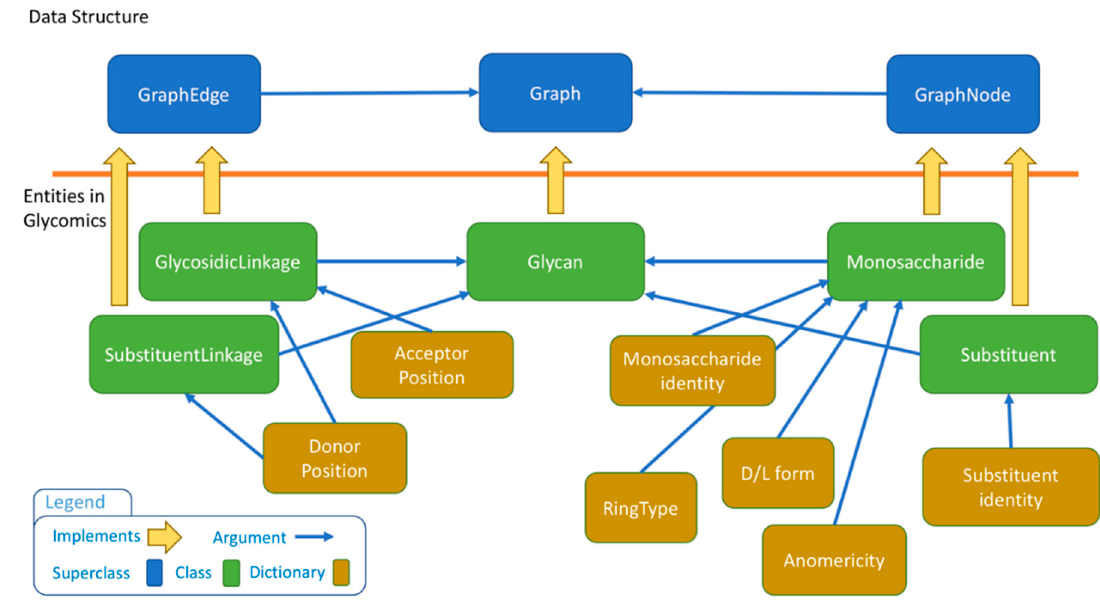
Figure 3. Entity relationships in the SugarSketcher data structure. The icon legend describes the color code for boxes.